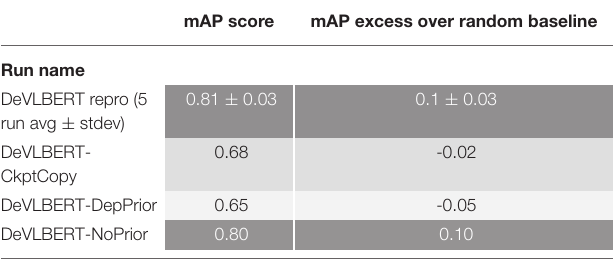
TABLE 5 | Comparison of confounder-finding performance of DeVLBERT with a random baseline. mAP score mAP excess over random